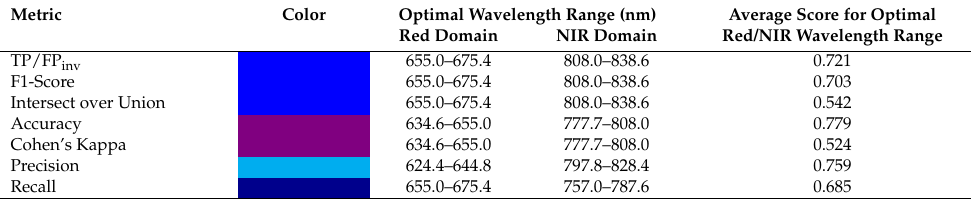
Table 3. Optimally suited wavelengths for burnt area detection, regarding different